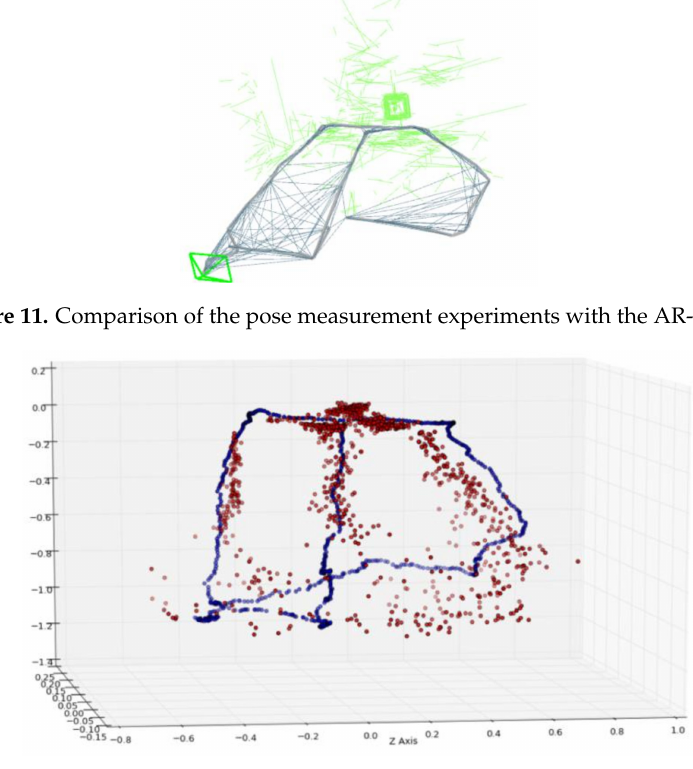
Figure 12. Analysis and contrast diagram of the experimental results. The blue scatter points Pb (Xb, Yb, Zb) represent the PL-SLAM positions. The red scatter points Pr (Xr, Yr, Zr) represent the AR-marker positions.